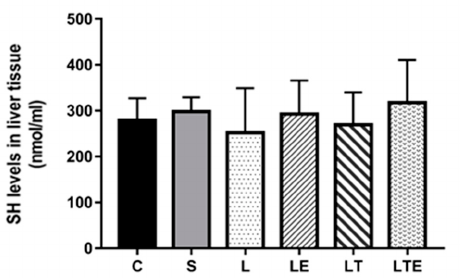
Figure 11. Assessment of SH levels in liver tissue. Sulfhydryl levels (nmol/mL) in the liver after intervention in the different group s : C , control group; S, sham group; L, injury group; LE, injury +